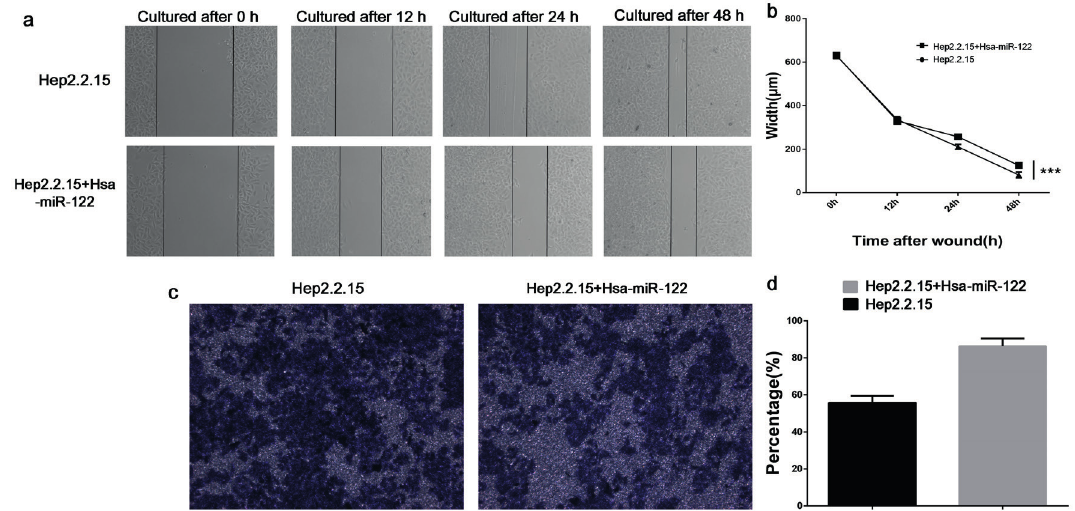
Figure 3 - Cell function test. a Wound healing assay. Two groups were cultured for 48 hours, and the result were quantitatively represented using the curve, which indicated that the observer group exhibited the lower degree of healing. b Transwell assay. After 24 hours of culture, a cell counter was used to calculate the percentage of cells in each field of view. A mobility of 60% was found in HepG2.2.15 cells treated with